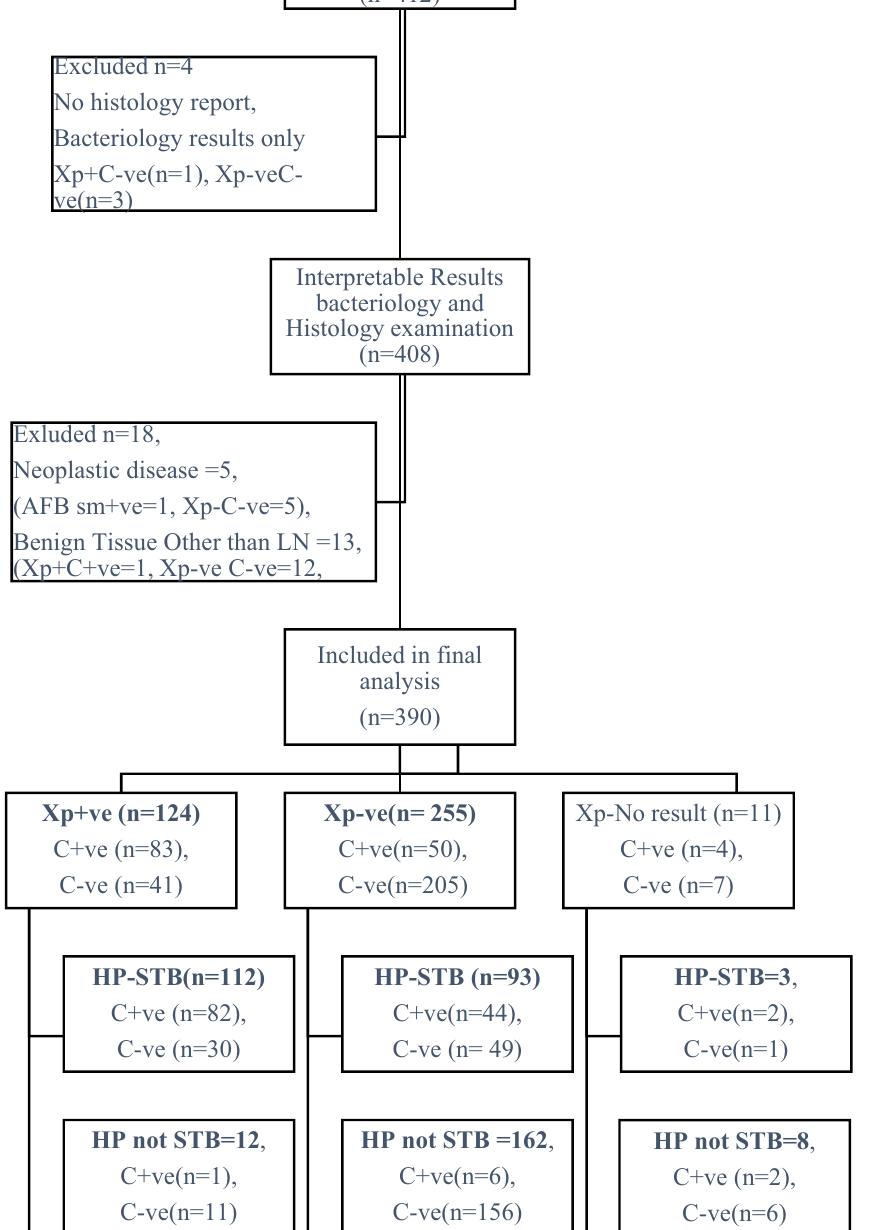
Figure 1. Flow diagram showing people investigated for enlarged lymph nodes presumed to have TB and the rapid molecular assay, histology, and culture examination